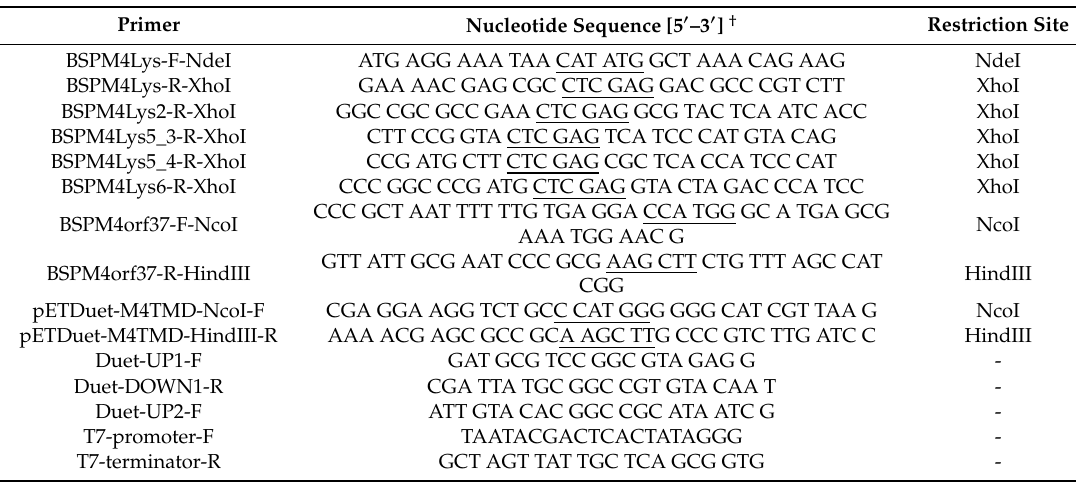
Table 2. Primers used in this